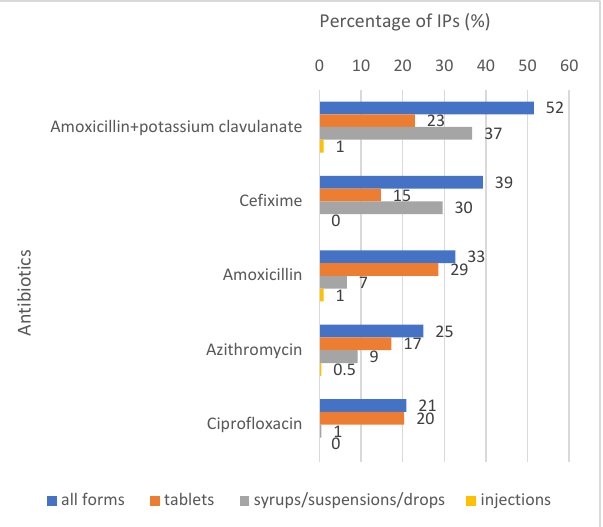
Figure 1. Top 5 antibiotic active ingredients (all formulations) stocked by IPs (N = 196) . Table 2. Top 5 antibiotic active ingredients stocked by IPs, by formulation (N = 196).